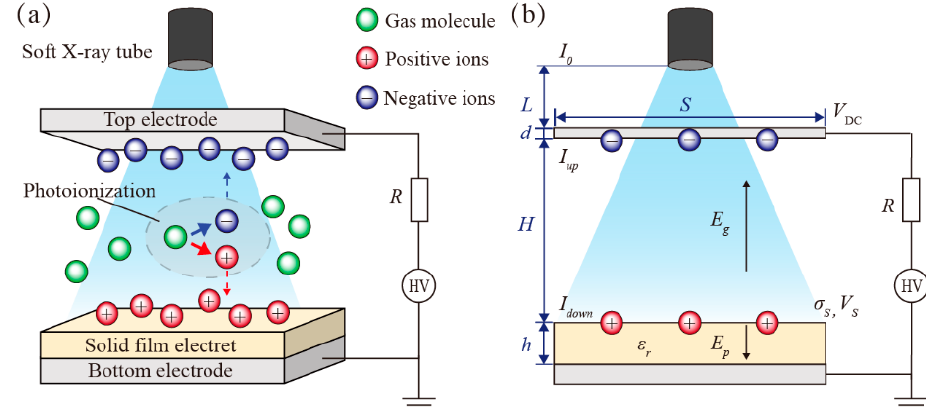
Figure 1. Soft X-ray charging solid-film electrets: ( a ) schematic of dynamic behavior of ions; ( b ) equivalent electrical model.